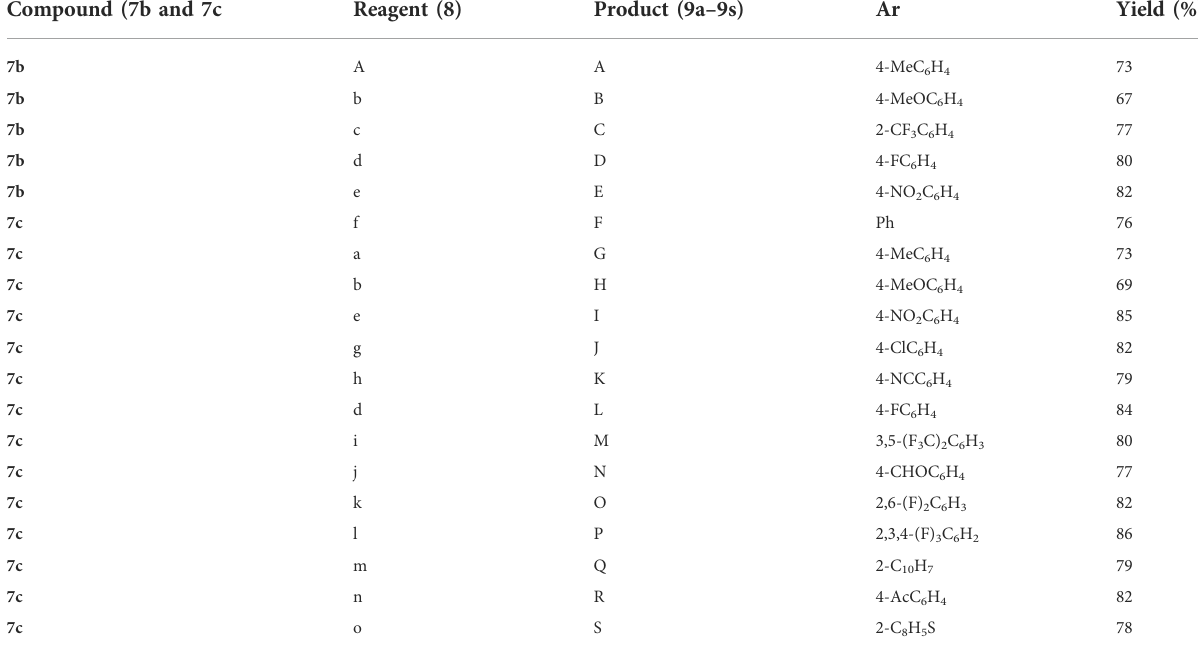
TABLE 1 Synthesis of cross-coupled 1H-1,2,3-triazole analogues (9a – 9s). Compound (7b and